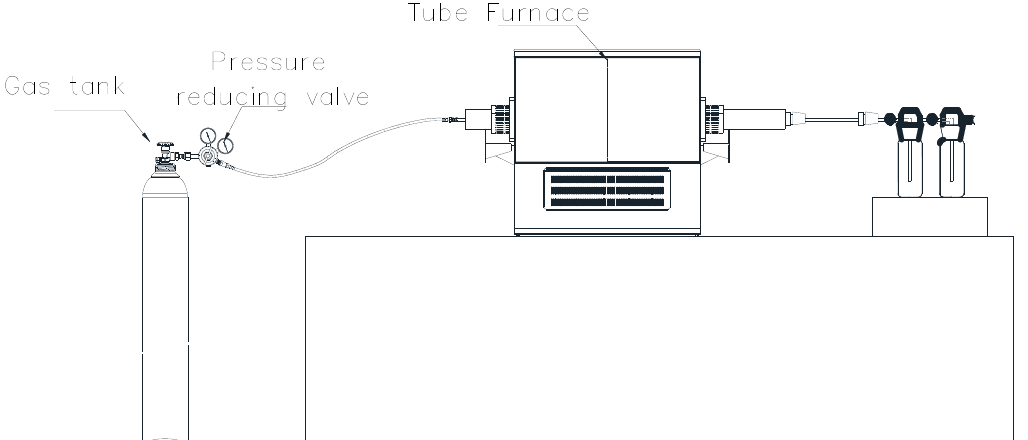
Figure 6. Schematic drawing of experimental apparatus.